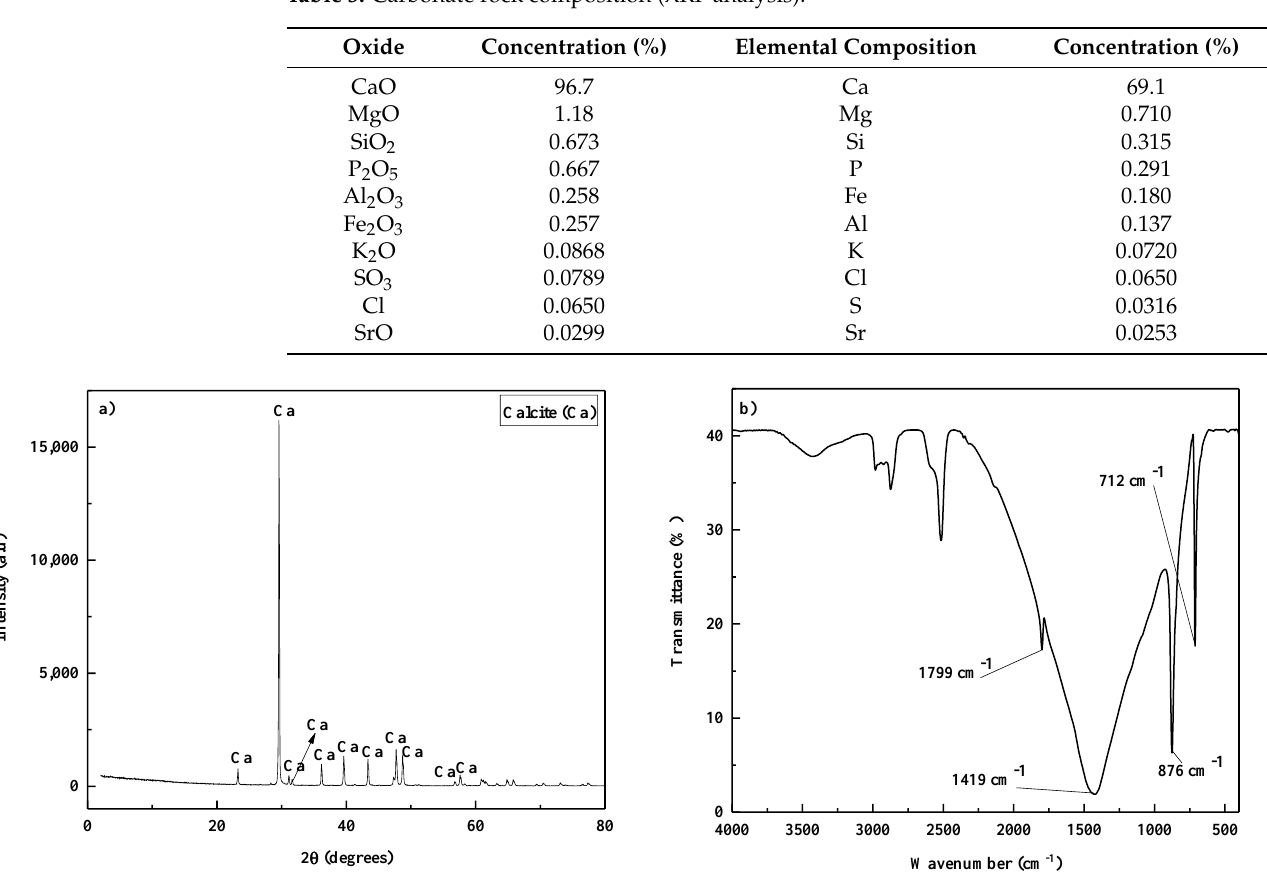
Figure 2. Characterization of a carbonate rock sample by ( a ) XRD and ( b ) FTIR.